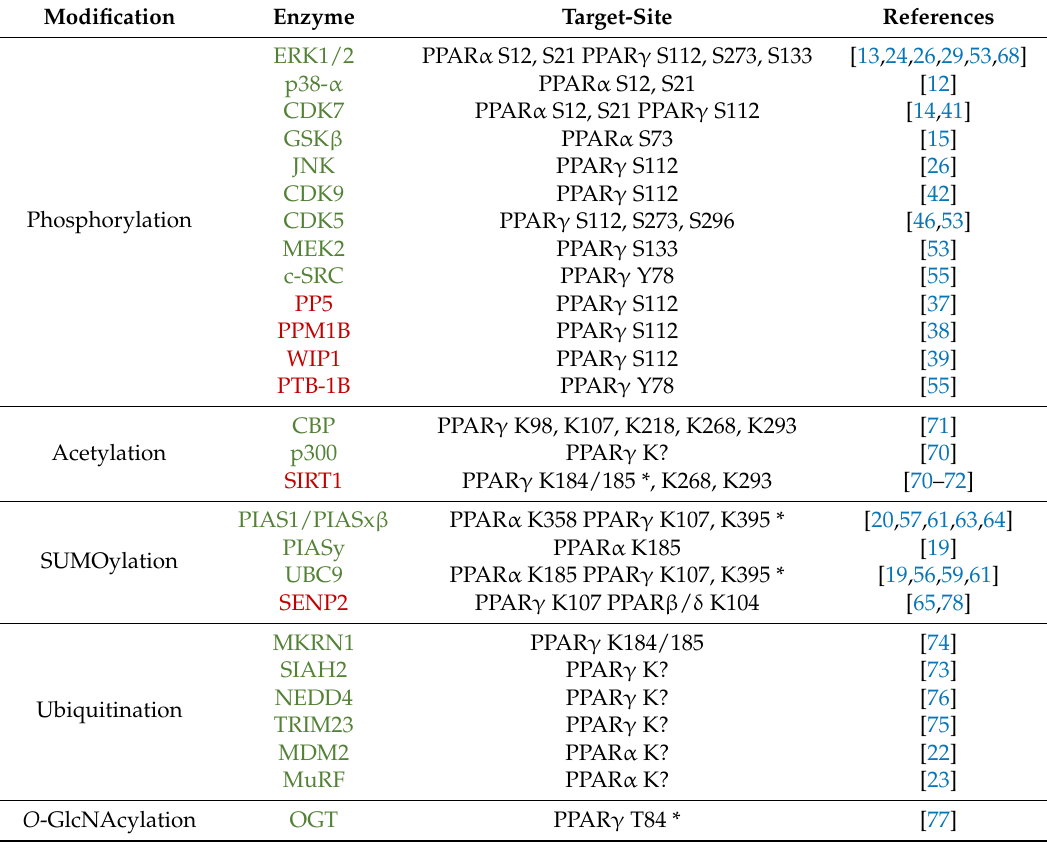
Table 1. Summary of PPAR modifying enzymes. Enzymes that deposit modifications are highlighted in green, while enzymes removing modifications are shown in red. For PPAR γ , amino acid sequence positions refer to PPAR γ 2. If there is only experimental evidence for modification in PPAR γ 1, the corresponding amino acid position in PPAR γ 2 is given and highlighted with an asterisk. Question marks indicate undetermined target